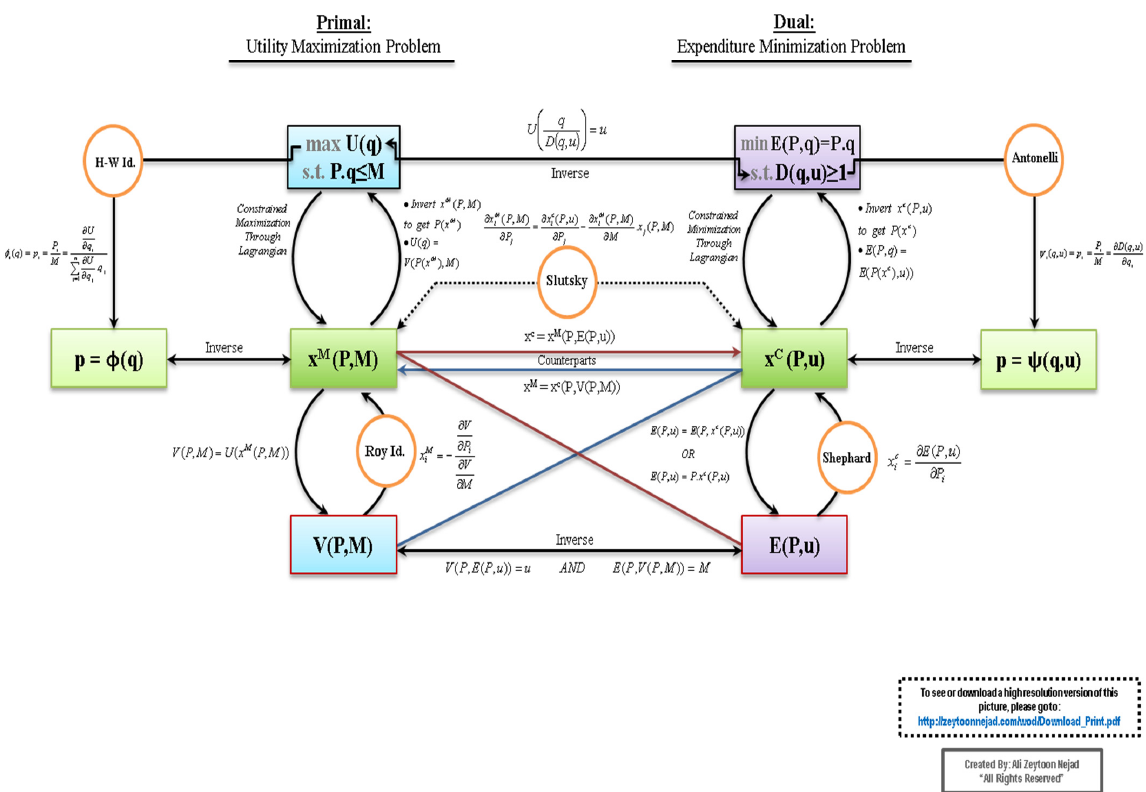
Figure A1. Wheel of duality in consumer theory—Source: Moosavian (2016).